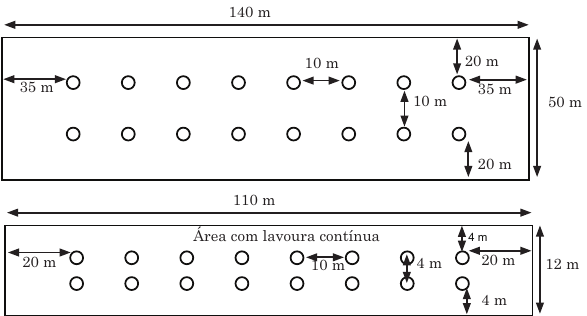
Figura 1. Esquema utilizado para determinar a resistência do solo à penetração nas áreas de pastagem e de lavoura